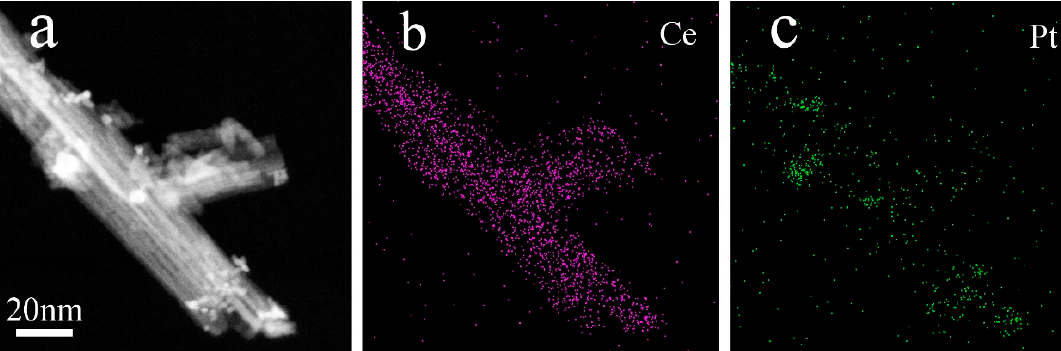
Figure 3. ( a ) Scanning transmission electron microscopy (STEM) image and element mapping of ( b ) Ce and ( c ) Pt in the Pt/CeO 2 catalyst prepared from the dealloyed Al 91.7 Ce 8 Pt 0.3 ribbon calcined at 300 °C.